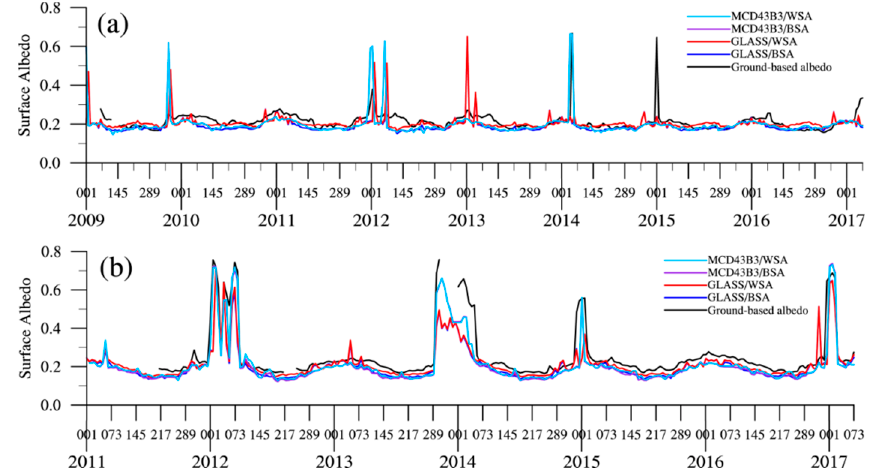
Figure 2. Comparison of the 8-day average albedo over the years between the GLASS, MCD43B3 albedo, and ground-based observation at ( a ) Maqu site from January 2009 to June 2017 and ( b ) Maduo site from January 2011 to June 2017. Table 3. Root mean square error (RMSE) and bias between GLASS, MCD43B3 albedo, and ground-based observation at (Figure 2a) Maqu site from January 2009 to June 2017 and (Figure 2b) Maduo site from January 2011 to June 2017.